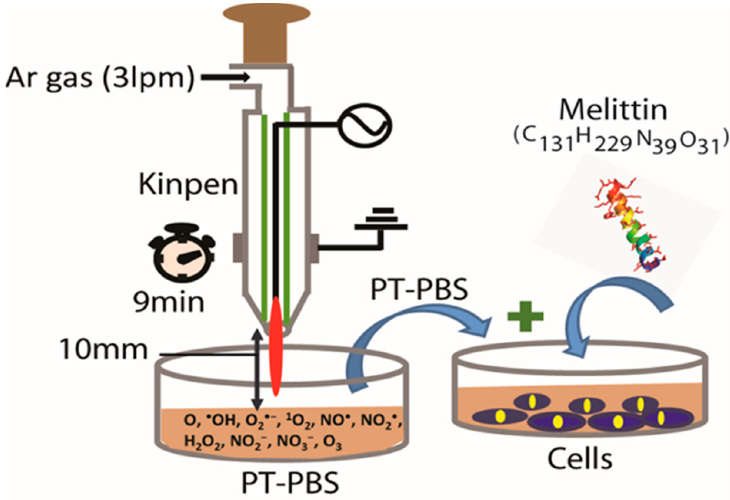
Figure 1. Schematic diagram of the kINPen ® IND device. Argon is used as feeding gas with a flow rate of 3 lpm (liter per minute).